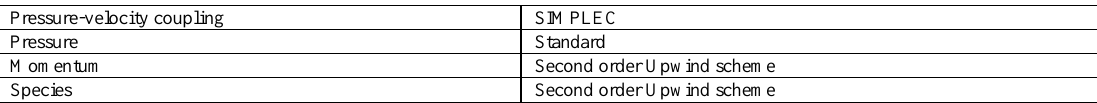
Table 2. The solution methods of numerical